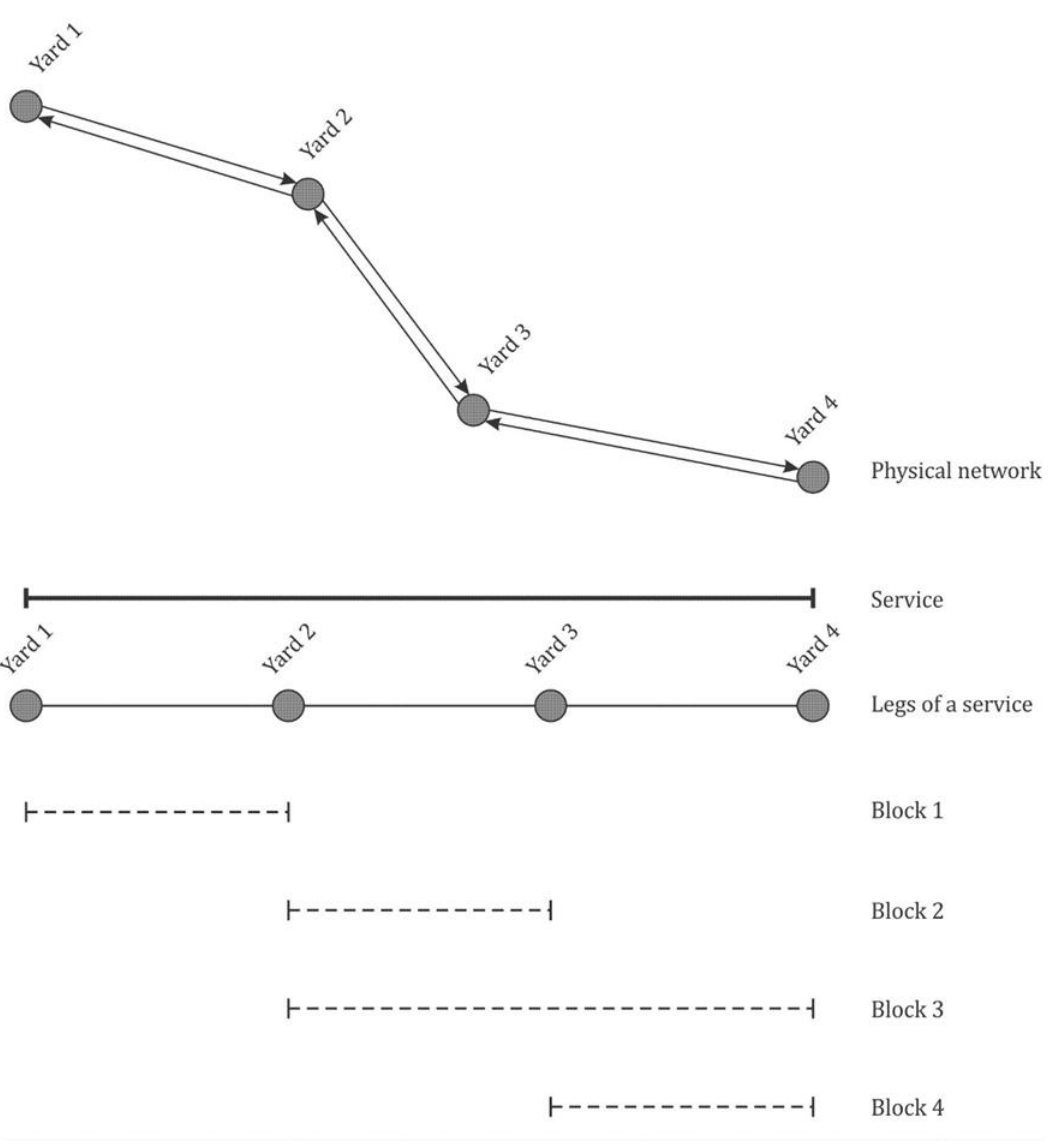
Figure 1. Representation of a railway network and